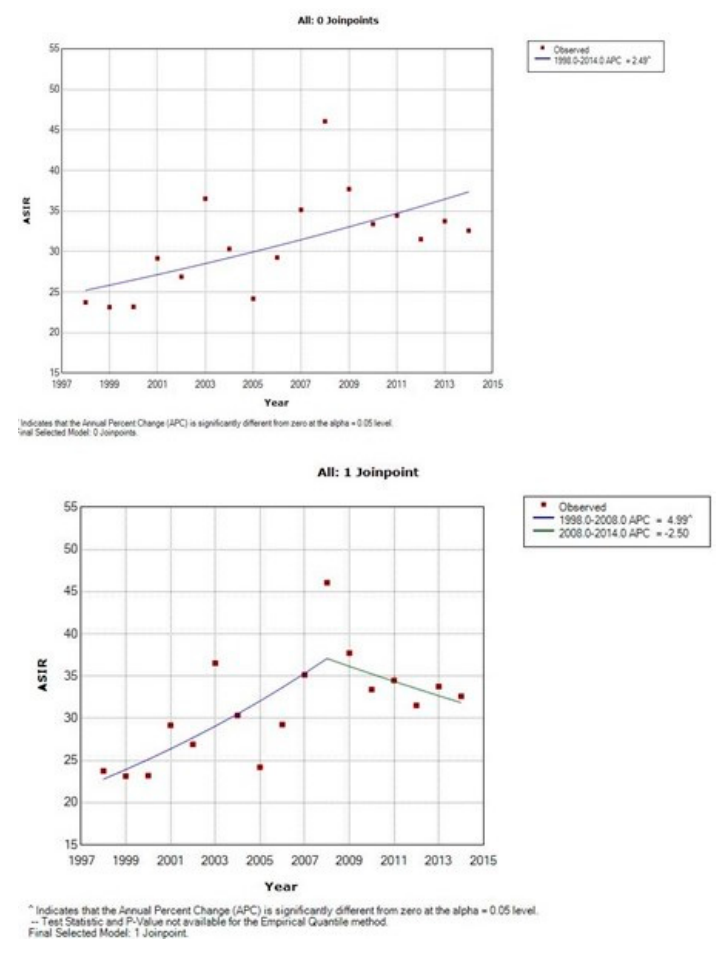
Figure 3. Time trends of age-standardized incidence rates of cervical cancer, Cluj County, 1998–2014.